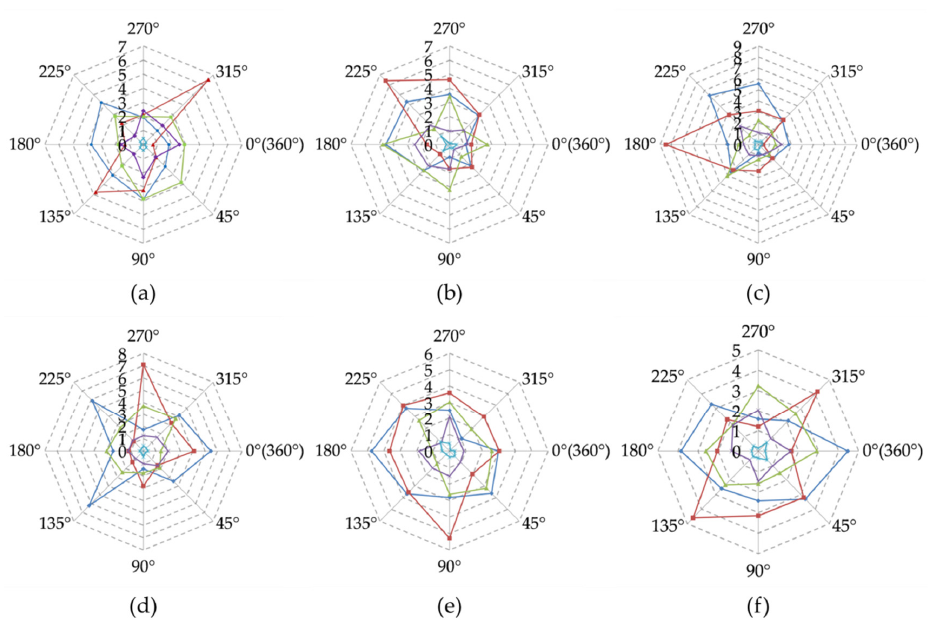
Figure 6. Normal force distribution on horizontal surface (unit: 10 − 3 N): ( a – f ) indicate the action of moisture content of 10.23%, 14.09%, 17.85%, 21.77%, 26.41%, 29.22% on the horizontal surface,